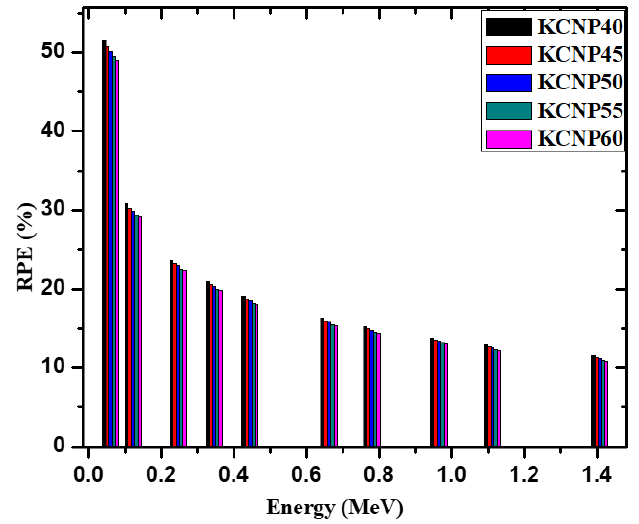
Figure 8. The radiation protection efficiency for the fabricated glasses.